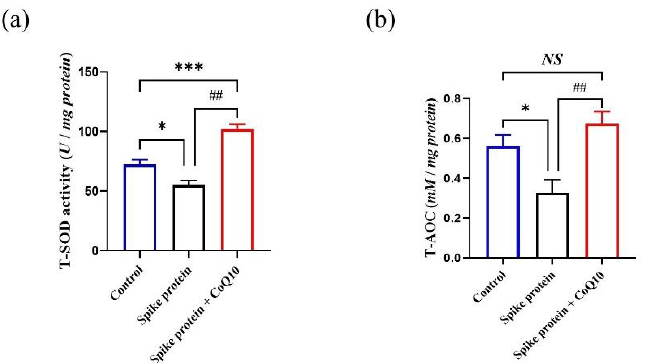
Figure 7. CoQ10 improves platelet antioxidative activity reduced by spike protein. Gel-filtered platelets were incubated with CoQ10 or solvent for 50 min, then incubated with spike protein for 10 min, then stimulated with thrombin for 10 min. ( a ) Platelets lysates were used for SOD activity analysis ( n = 4). ( b ) Platelets lysates were used for T-AOC level measurement ( n = 5). All data are presented as mean ± SEM. * p < 0.05, *** p < 0.001 indicate a significant difference compared to the control group. ## p < 0.01 indicates a significant difference between two groups. NS , no significant difference between two groups.